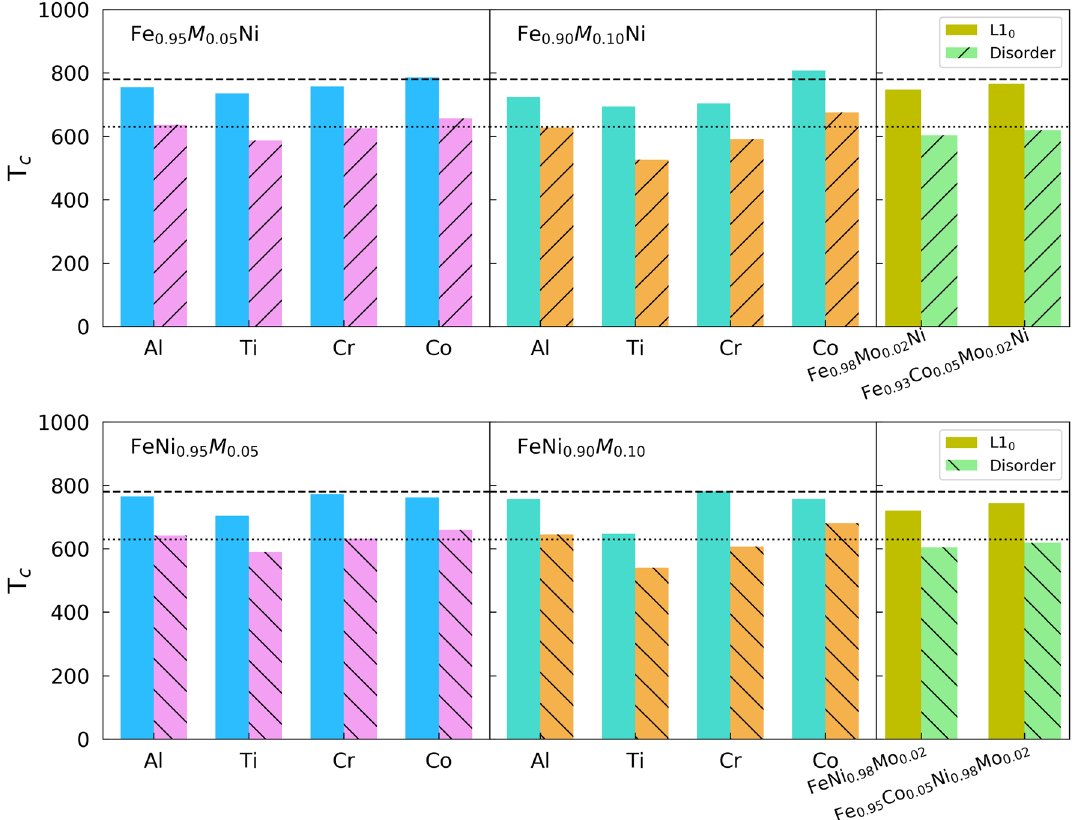
Figure 5. The Curie temperatures of Fe 1 − x M x Ni and FeNi 1 − x M x ( M = Al , Ti, Cr, Co), and Fe 0.98 Mo 0.02 Ni , FeNi 0.98 Mo 0.02 , Fe 0.93 Co 0.05 Mo 0.02 Ni and Fe 0.95 Co 0.05 Ni 0.98 Mo 0.02 are shown. The dashed lines show the T c (780 K) of L1 0 FeNi, and the dotted lines show the T c (630 K) of fully random FeNi, respectively.